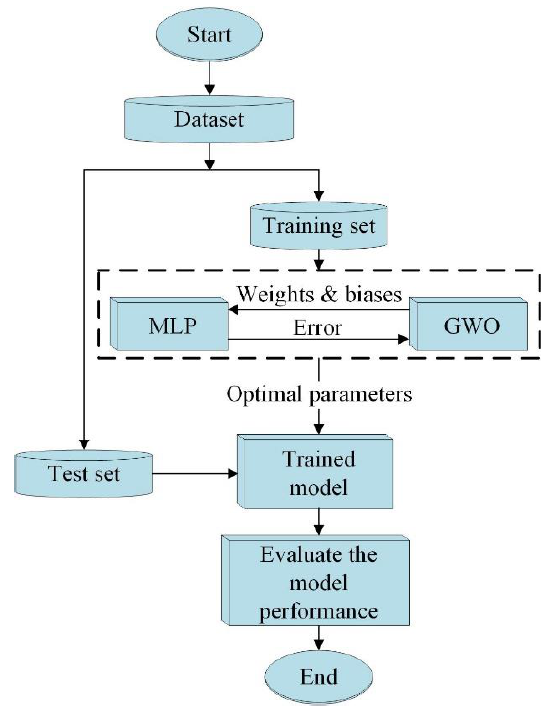
Figure 5. Flow chart of the hybrid MLP-GWO model.